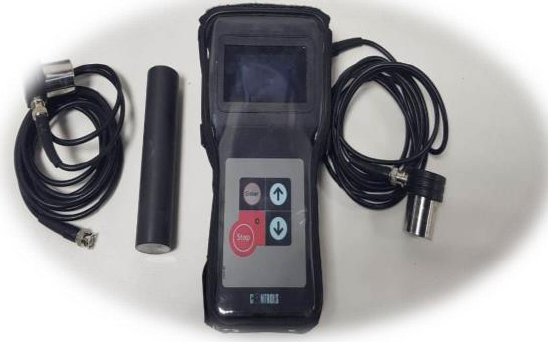
Table 6. Velocity criteria for concrete quality grading [2].